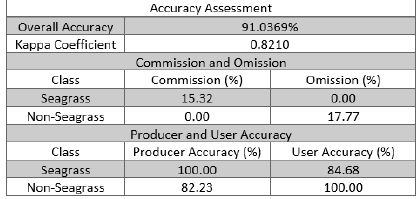
Table 3: Accuracy